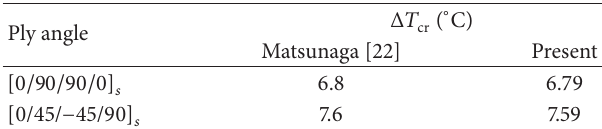
Table 2: Comparison of critical buckling temperature for composite